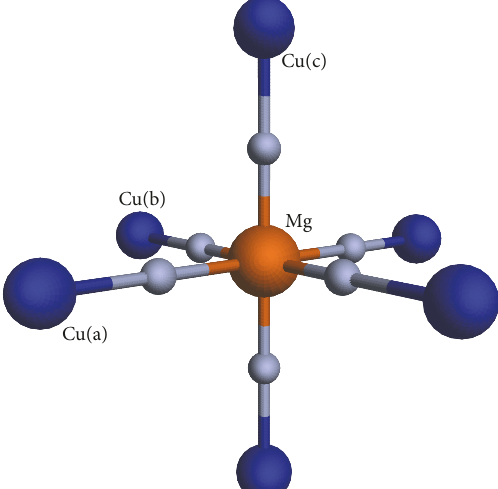
Figure 4: Stick-and-ball representation of the atoms surrounding Mg in the doped compound. Mg is 2.20 and 1.94 ˚A from fluorine atoms shared with Cu(a) and Cu(b),